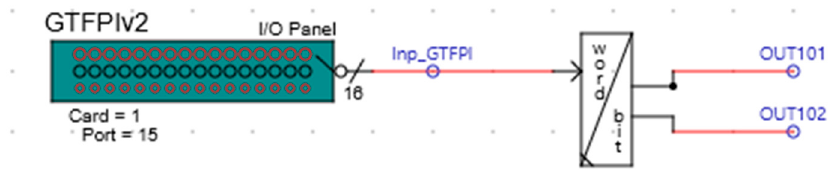
Figure 16. GTFPI element in RSCAD.